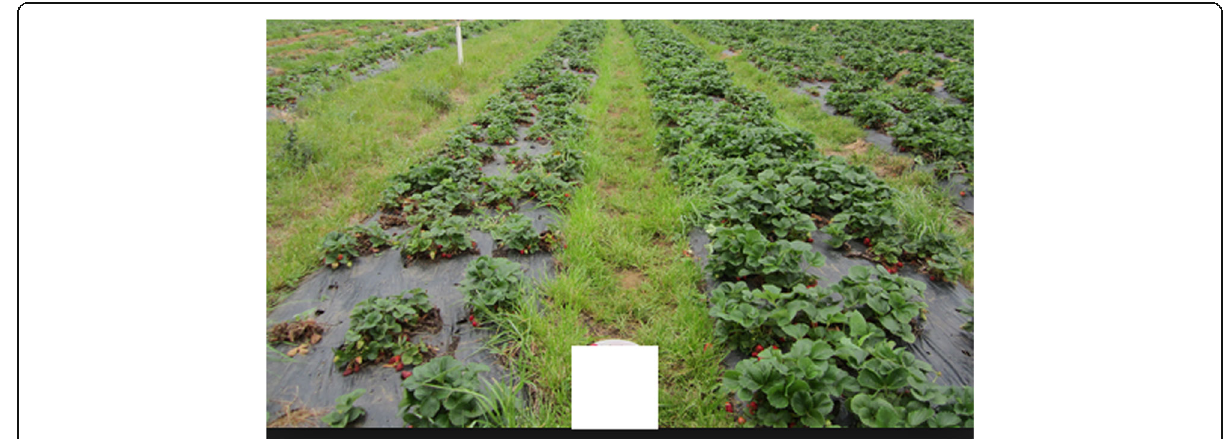
Fig. 1 A strawberry field showing patchy area due to root-knot nematode